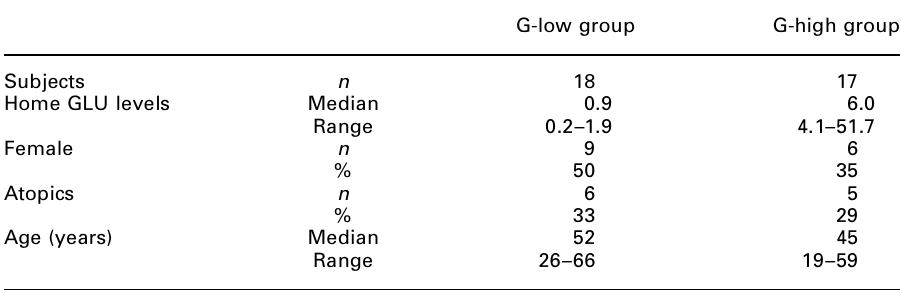
Table 1. Population characteristics and levels of (1 ® 3)- b - D -glucan (GLU) in the home (ng/m 3